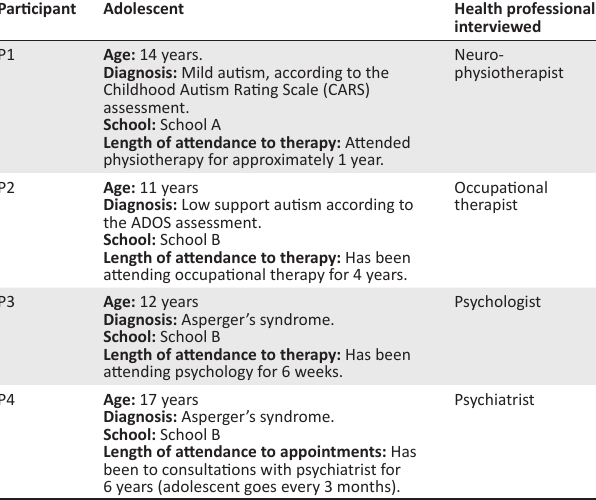
TABLE 1: Demographics of the participants.